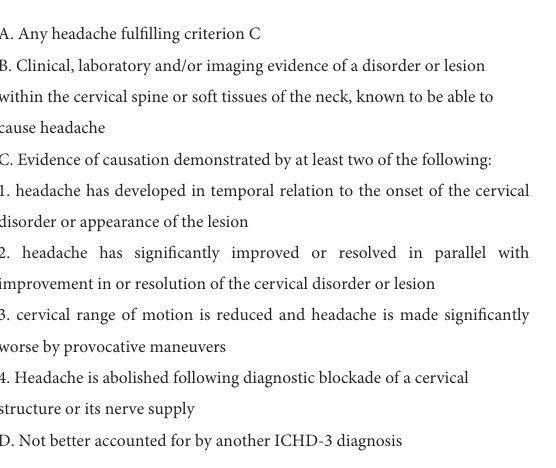
TABLE 1 The diagnostic criterions recommended by the international classification of headache disorders, ICHD 3rd edition.